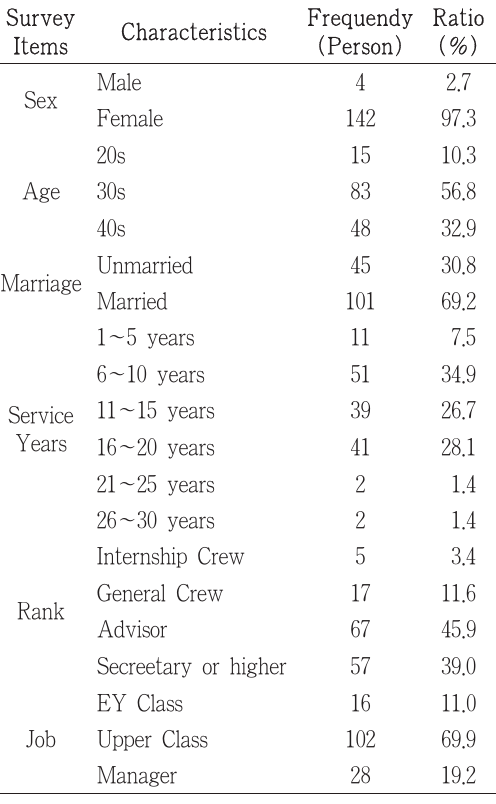
<Table 1> General characteristics of